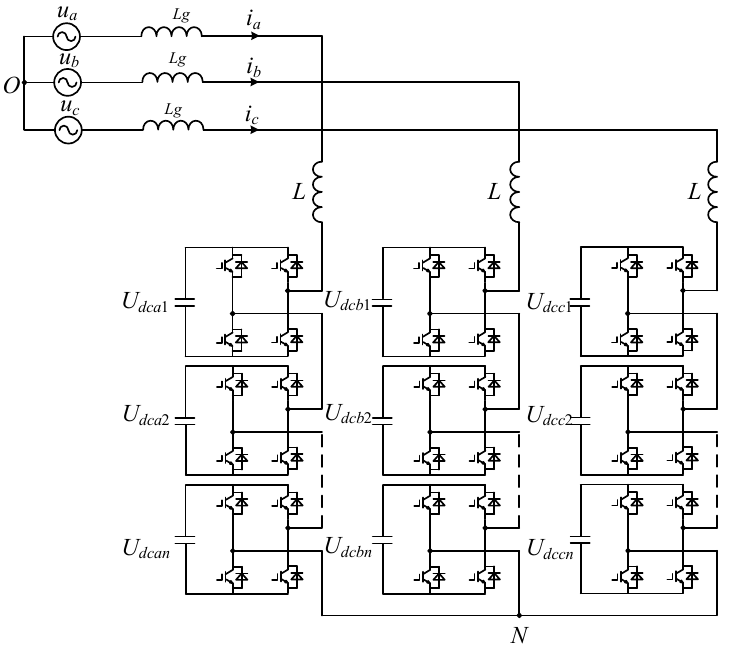
Figure 1. Topology of the star-connected SVG.